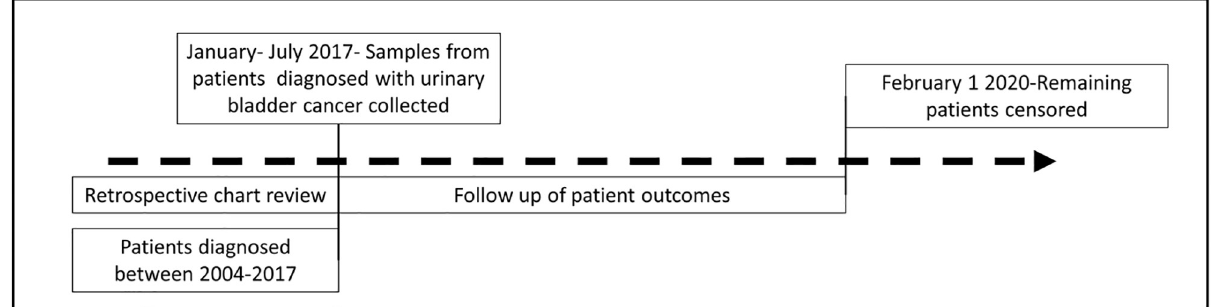
Fig 1. Study flow diagram. Urinary bladder cancer study. Mt Sinai hospital system and North Shore Long Island Jewish health system, New York, New York. 2004–2017.